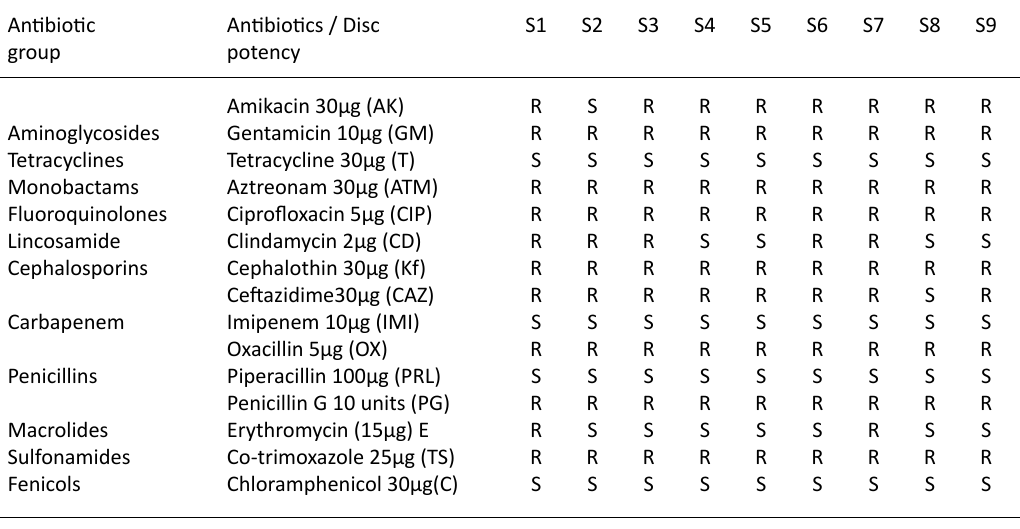
Table 5. Antibiotic susceptibility of the selected promising EPS producing isolates using antibiotic discs Antibiotic Antibiotics / Disc